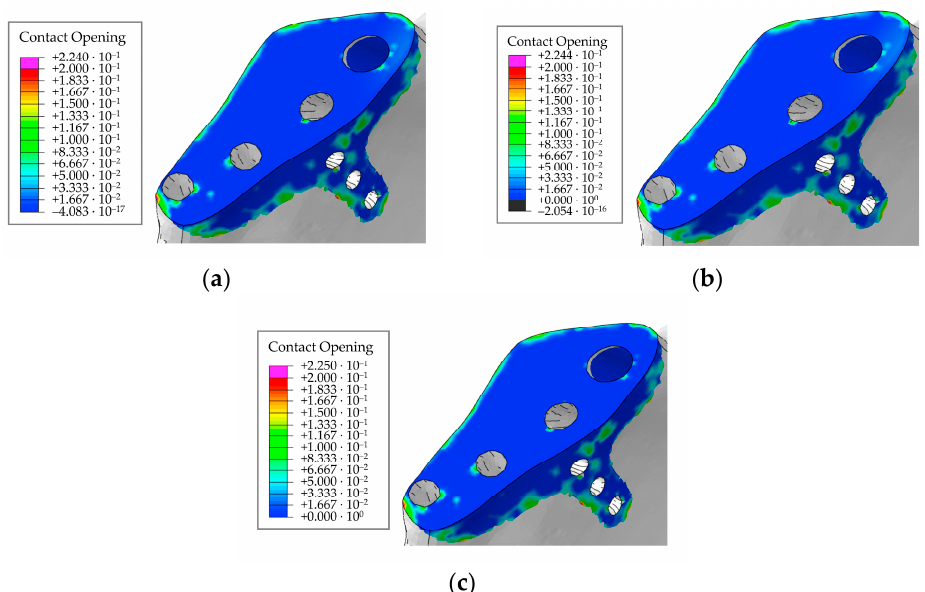
Figure 31. Maximum clearance between the contact surfaces over all loading steps: ( a ) for pretension force of 500 N; ( b ) for pretension force of 50 N; ( c ) initial state, MPa.